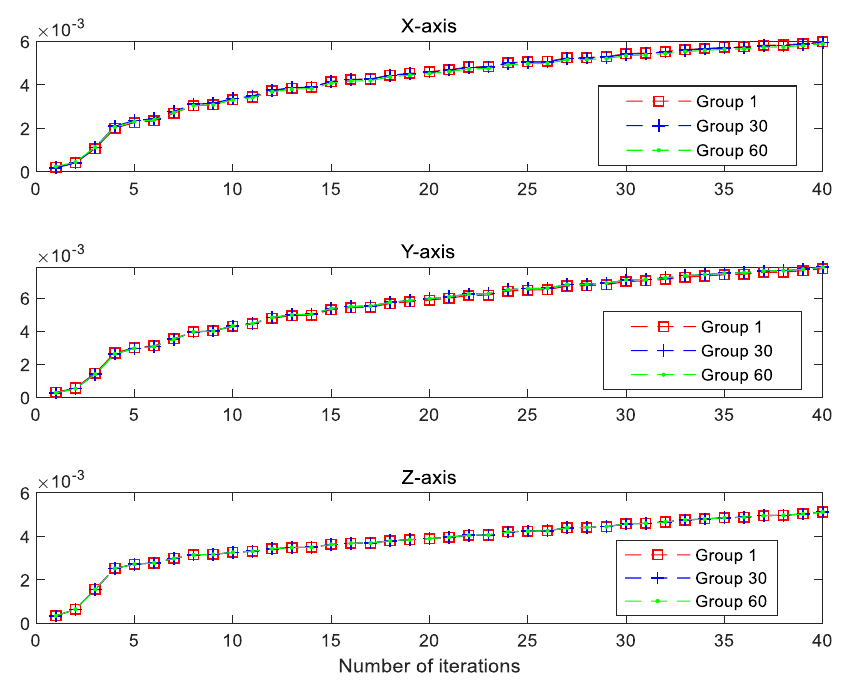
Figure 2. Gyroscope meter − scal − factor estimation results.